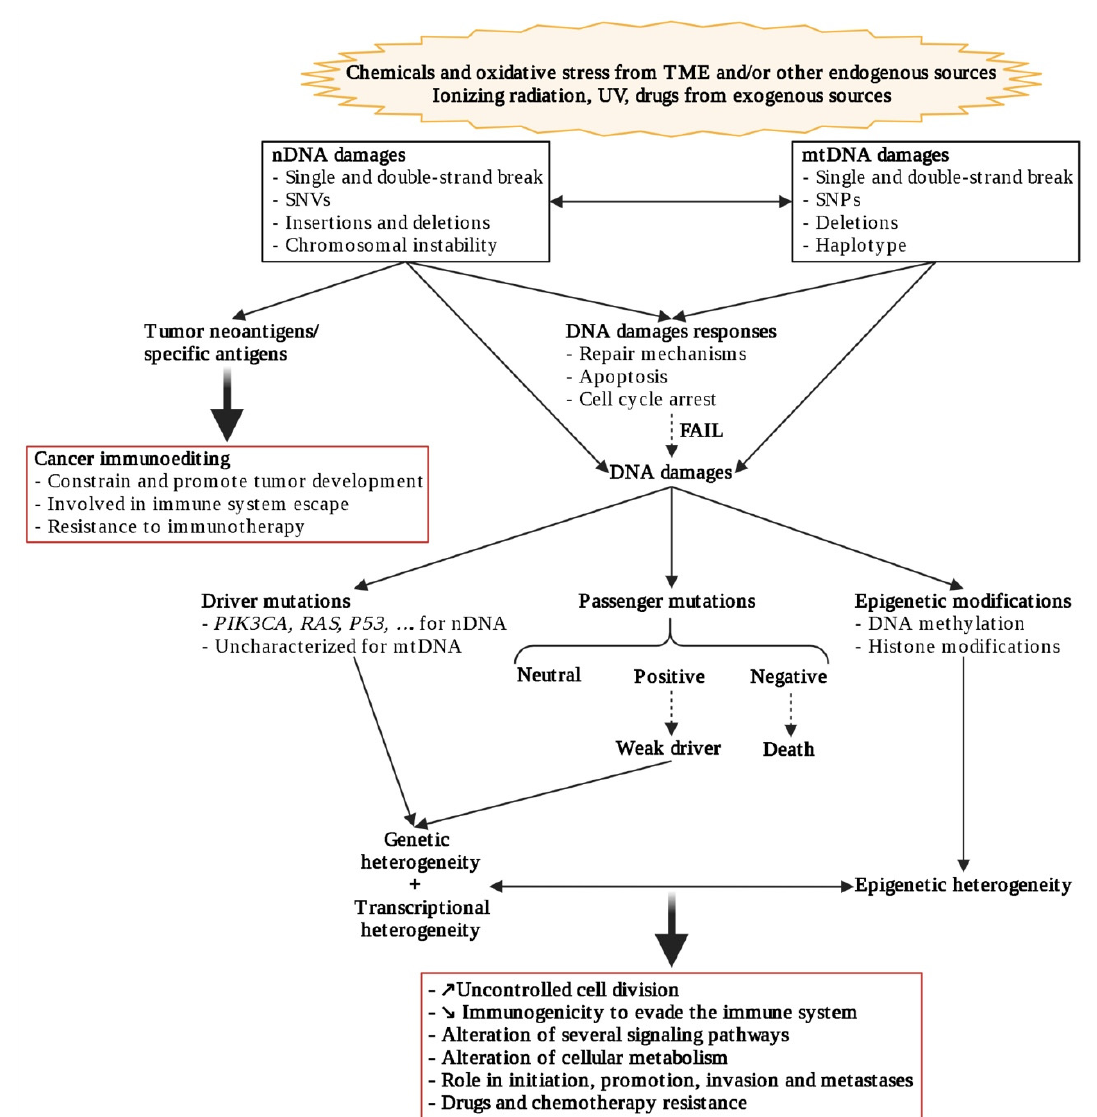
Figure 2. Genetic, transcriptional, and epigenetic heterogeneity communications. Created with BioRender.com(accessed on 2 January 2021).